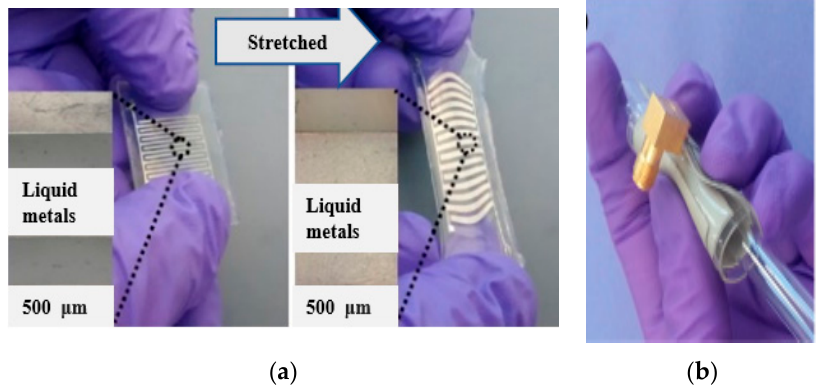
Figure 3. Different flexible materials. ( a ) Stretchable PDMS [171], ( b ) rolled patch antenna [173]. Table 3. Properties of the substrate [96,176].